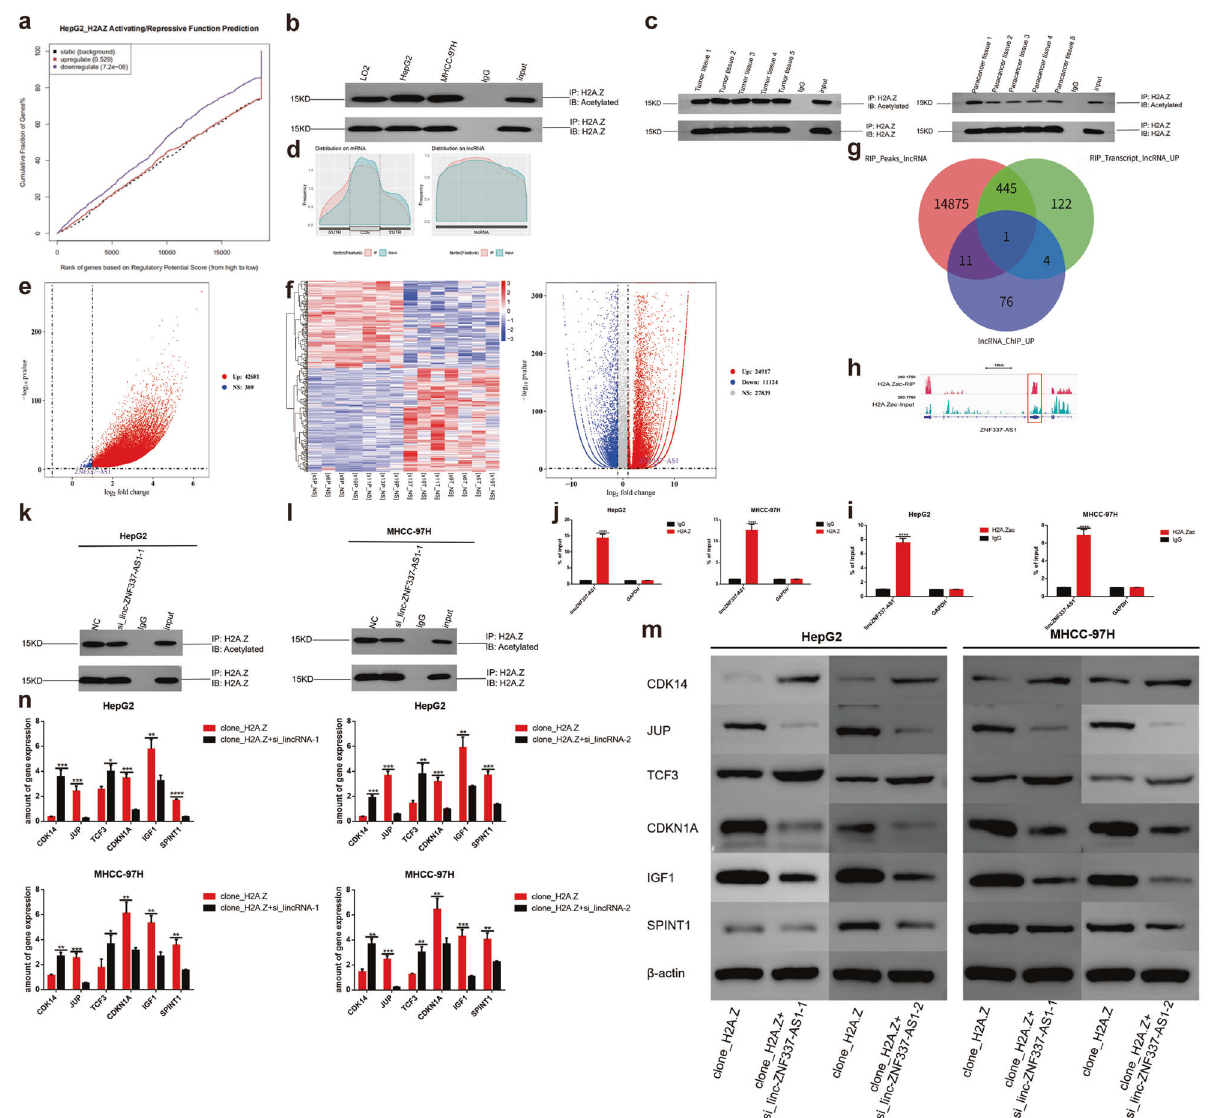
Fig. 5 LincZNF337-AS1 binds to H2A.Z and H2A.Zac, and regulates the acetylation of H2A.Z. a H2A.Z mainly promoted the transcription of downstream genes(Software: BETA, algorithm: basic-k BSF-df 0.05). b The acetylation level of H2A.Z was detected by Co-IP in HCC cell lines. c The acetylation level of H2A.Z was detected by Co-IP in HCC tissues. d RIP with H2A.Zac antibody in HepG2 cells and sequencing. e Volcanograms of lincRNA identi fi ed by RIP-seq(Software: ggplot2, R package). f Heat maps and volcanograms of the seven pairs of HCC and paired paracancer tissues analyzed by RNA-seq(Software: R pheatmap, R package). g Venn diagram of RIP-seq and lincRNA highly expressed in tumors in RNA-seq. h IGV diagram of lincZNF337-AS1. i – j Identi fi cation of lincZNF337-AS1 binding to H2A.Z and H2A.Zac by RIP-qPCR. k – l LincZNF337-AS1 regulates the acetylation of HCC, the level of acetylation was measured by Co-IP. m , n QRT-PCR, and western blot veri fi ed the changes of downstream target genes after lincZNF337-AS1 knockdown in H2A.Z overexpressed HCC cell lines. The data are expressed in terms of mean ± SD (Student ’ s t -test used in Fig i , j , and n ; ** P < 0.01; *** P < 0.001; **** P < 0.0001; n = 3 in each H2A.Z were altered, which further indicated lincZNF337-AS1- binding to H2A.Z to affect the transcription of downstream genes (Fig. 5M, N). To predict the region of lincZNF337-AS1 responsible for interacting with H2A.Z, a series of lincZNF337-AS1 truncations were analyzed, and probabilities of their interacting with H2A.Z predicted (Fig. 6A). The fi nal exon-truncated fragment sequences were loaded into a vector and co-transfected into HEK293T cells with the H2A.Z-overexpression vector. The experimental results from the RIP assay, using the H2A.Z antibody, con fi rmed the interaction between H2A.Z and lincZNF337-AS1 at two sites (Fig. 6B). Finally, the truncated sequence was transcribed into RNA in vitro (Fig. S5A-B, Table S5), and the binding sites of lincZNF337-